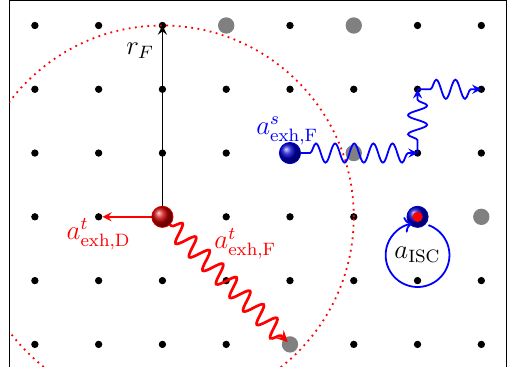
Figure 6. Schematic diagram illustrating the hopping processes of singlet (blue spheres) and triplet (red spheres) excitons. The black dots represent the organic material, while gray dots label dopant sites. FRET is shown for a triplet exciton hopping between dopant sites within the Förster radius r F . The Dexter type energy transfer is possible between all adjacent sites. The intersystem crossing is visualized for a singlet exciton in proximity to the dopant as a conversion of a singlet to a triplet